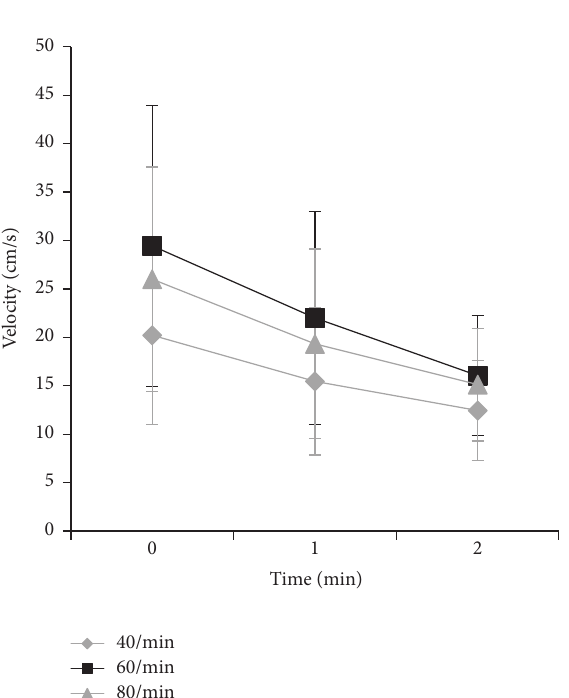
Figure 4: Velocity of blood flow in the profunda femoris after active ankle movement 2 days after total hip arthroplasty (mean ± standard deviation). The velocity of venous blood flow after active ankle movement at 60 contractions per minute was significantly faster thanthoseafteractiveanklemovementat40and80contractionsper minute ( 𝑝 = 0.0007 , repeated-measures ANOVA). The horizontal line indicates the time after active ankle